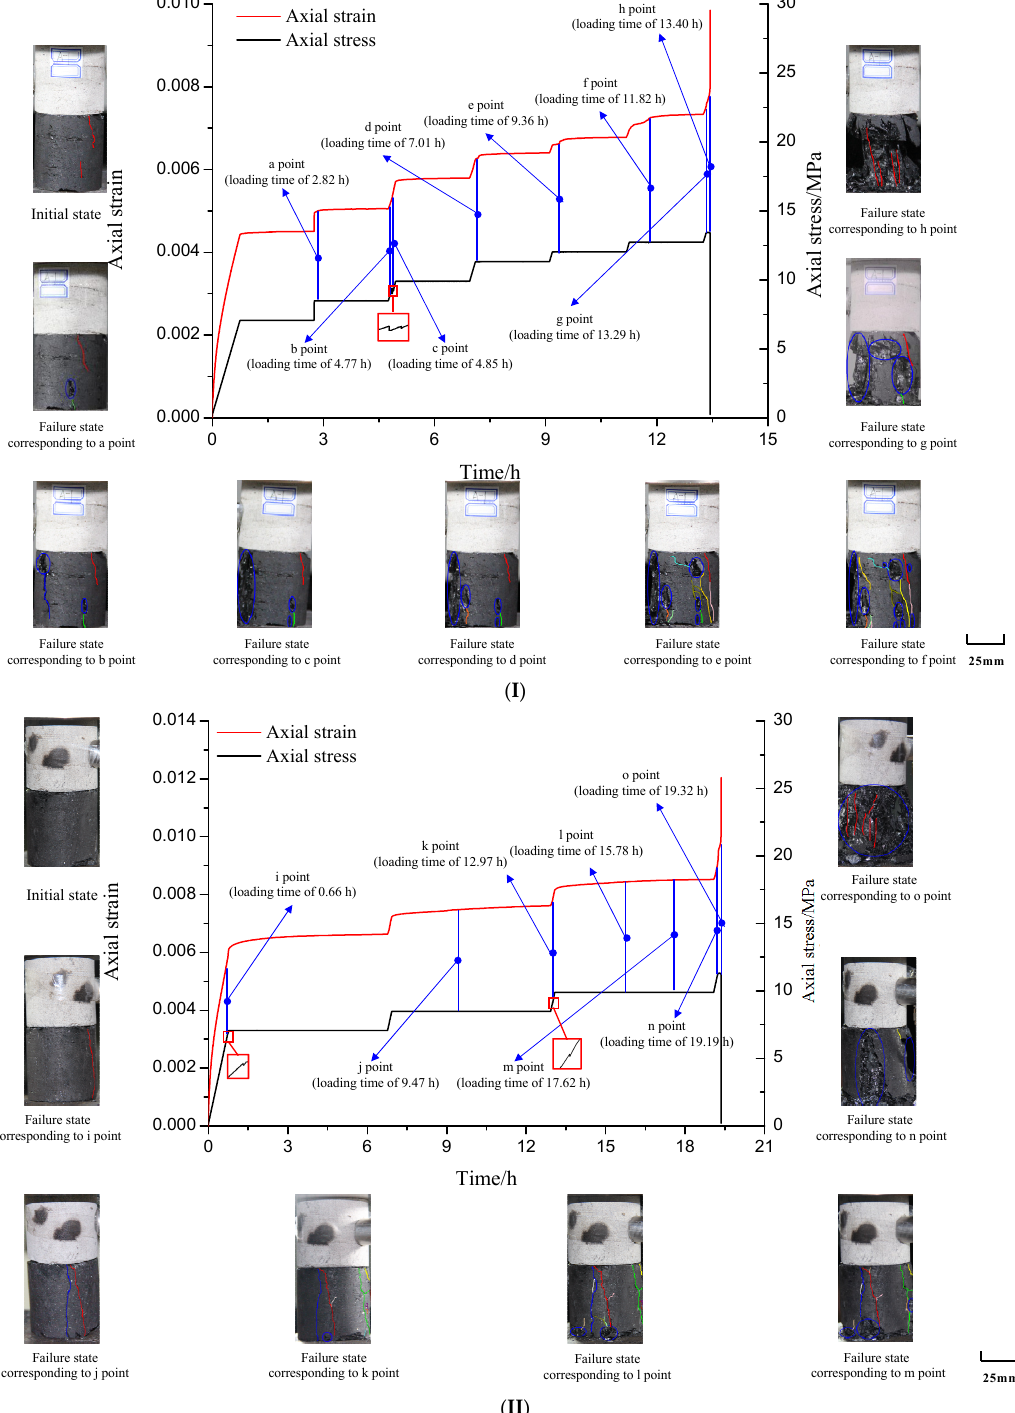
Figure 17. Macro-progressive failure processes of composite samples (the scale bar between the sample size in the figure and that of the real sample is 1:2.5): ( I ) Macro-progressive failure process of A-1 composite sample; ( II ) Macro-progressive failure process of B-3 composite